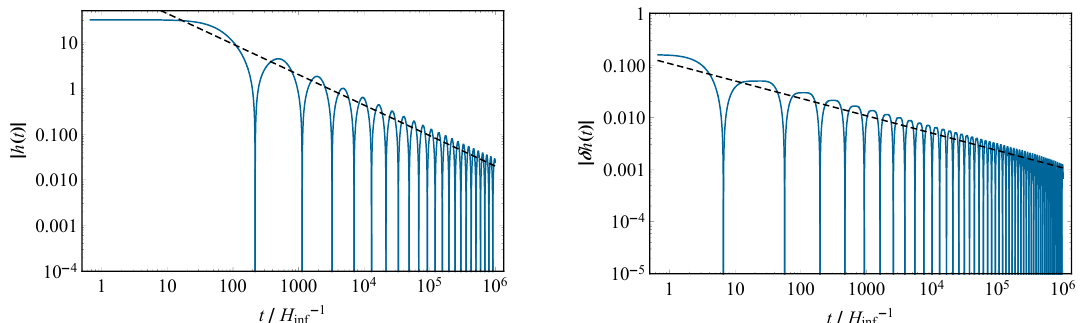
Figure 3 . Left: j h 0 ( t ) j as a function of time t . Right: j (cid:14)h ( t ) j as a function of time t . In both panels the blue solid curves represent numerical solutions of (3.3), while black dashed curves correspond to analytical (cid:12)ts (3.4). For illustration we take (cid:21) = 0 : 01 and (cid:14)h ini = 0 :